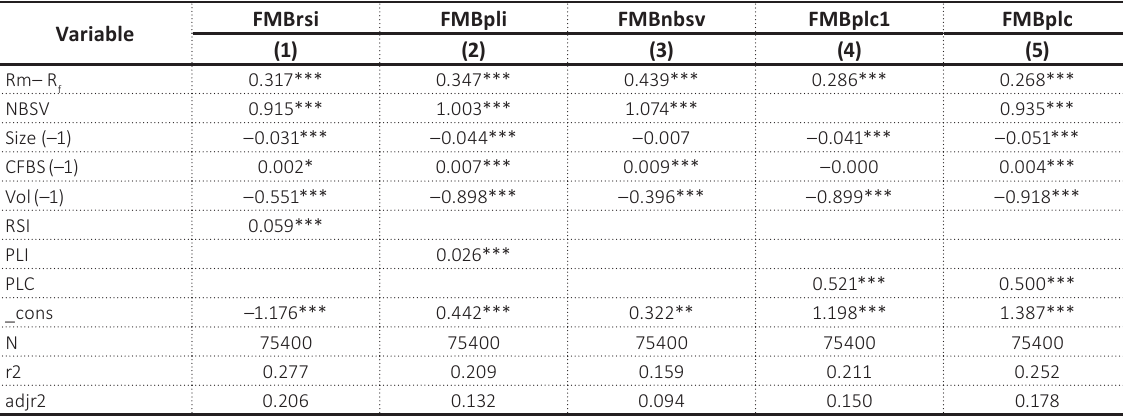
Table 4. Regression results according to the Fama-MacBeth